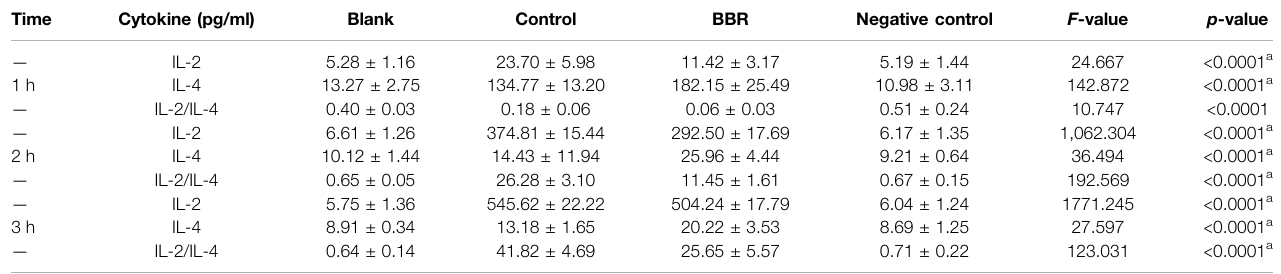
TABLE 1 | IL-2/IL-4 ratios. Time Cytokine (pg/ml)